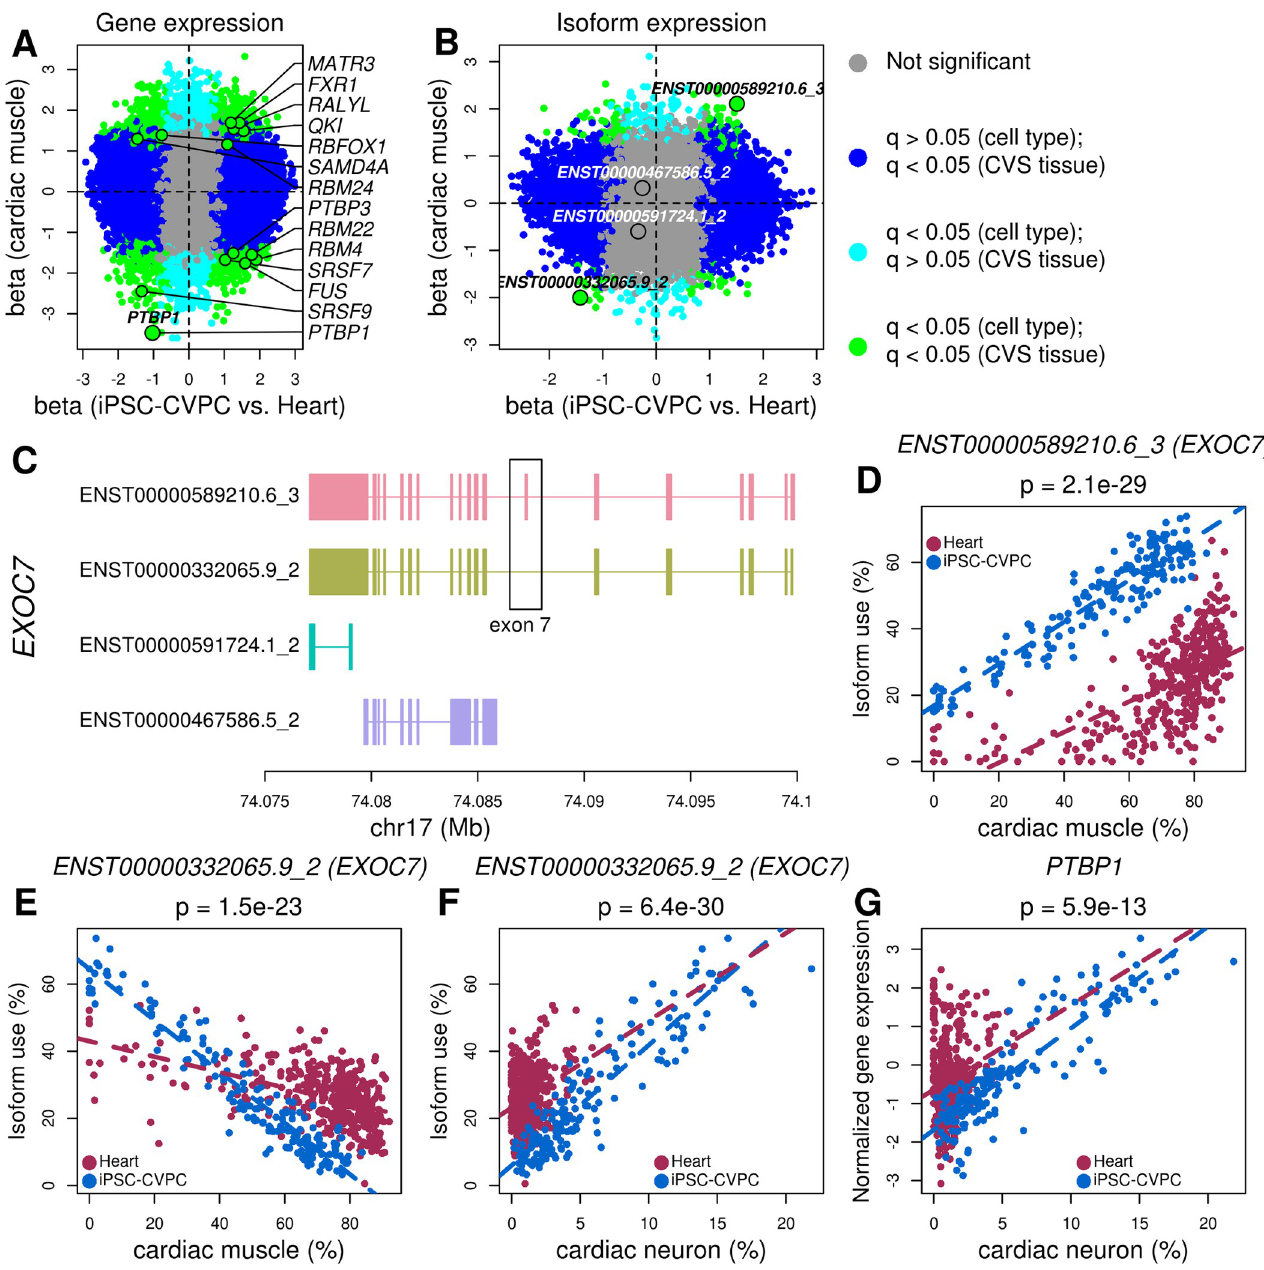
Fig 5. Differential RBP expression associated with developmental stage- and cell type-specific usage of isoforms. (A, B) Scatterplots showing differential (A) gene and (B) isoform expression effect size between iPSC-CVPC and adult heart (X axis) and the effect size of the association between expression and proportion of cardiac muscle (Y axis). Genes and isoforms significantly associated with both CVS tissue and cardiac muscle proportion are shown in green; genes and isoforms associated only with cell type are in blue; genes and isoforms that are associated only with CVS tissue are in cyan; genes and isoforms not associated with either CVS tissue or cell type proportion are shown in gray. PTBP1 is shown in (A) and the four EXOC7 isoforms are shown in (B). (C) Exon structure of the isoforms of EXOC7 . The two isoforms (ENST00000589210.6_3 and ENST00000332065.9_2) differentially expressed between iPSC-CVPC and adult heart differ in the presence or absence of exon 7. (D-F) Scatterplots showing the association between isoform use (%) and cell type proportion for (D, E) cardiac muscle or (F) cardiac neuron (X axis) in iPSC-CVPC and adult heart (Y axis) for the two most commonly expressed isoforms of EXOC7 . Dashed lines represent regression lines calculated on each CVS tissue. P-values represent the association between the use of each isoform and the cell type proportions (cardiac muscle in panels D and E, cardiac neuron in panel F). (G) Scatterplot showing the association between the normalized expression of PTBP1 and the proportion of cardiac neuron (X axis) in iPSC-CVPC and adult heart. Dashed lines represent regression lines calculated on each CVS tissue. P-value represent the association between the PTBP1 expression and the cardiac neuron proportion.